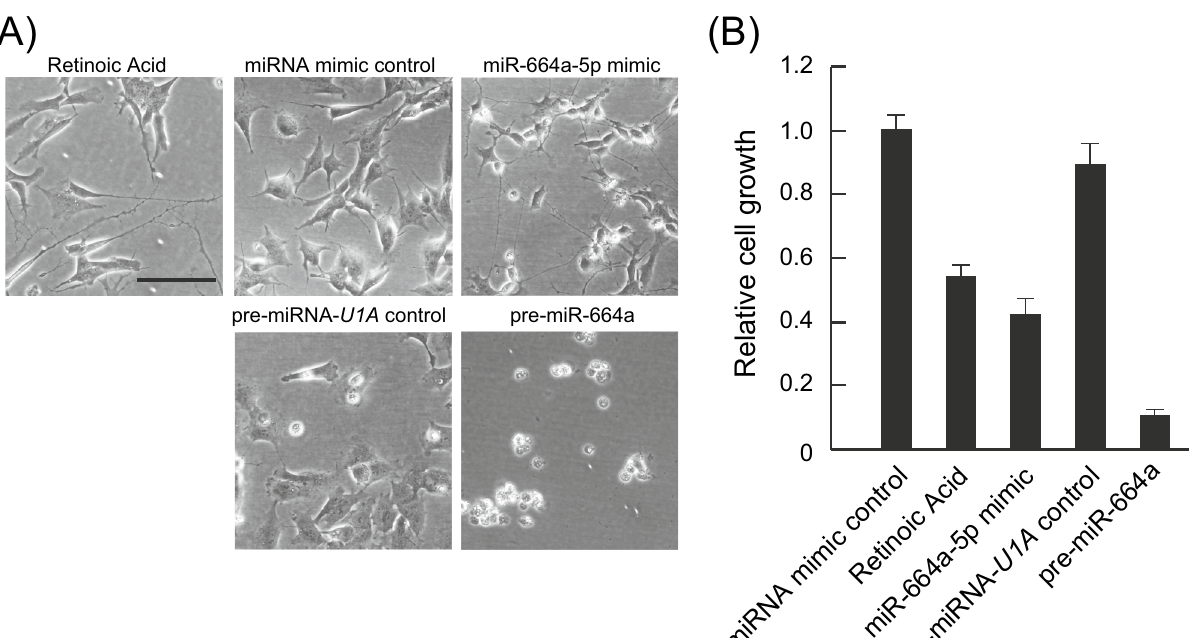
Figure 1. Pre-miR-664a inhibits growth and induces cell death in SH-SY5Y cells. ( A ) Phase contrast images of SH-SY5Y cells transfected with miR-664a-5p, pre-miR-664a, miRNA mimic, or pre-miRNA- U1A control using Lipofectamine RNAiMAX. Retinoic acid induced SH-SY5Y cell differentiation. Scale bars indicate 100 µm. ( B ) The viability of SH-SY5Y cells transfected with miR-664a-5p, pre-miR-664a, miRNA mimic, or pre-miRNA- U1A control using Lipofectamine RNAiMAX. Cell viability was normalized to the viability of cells treated with miRNA mimic control. Data represent the means ± SEM of three independent